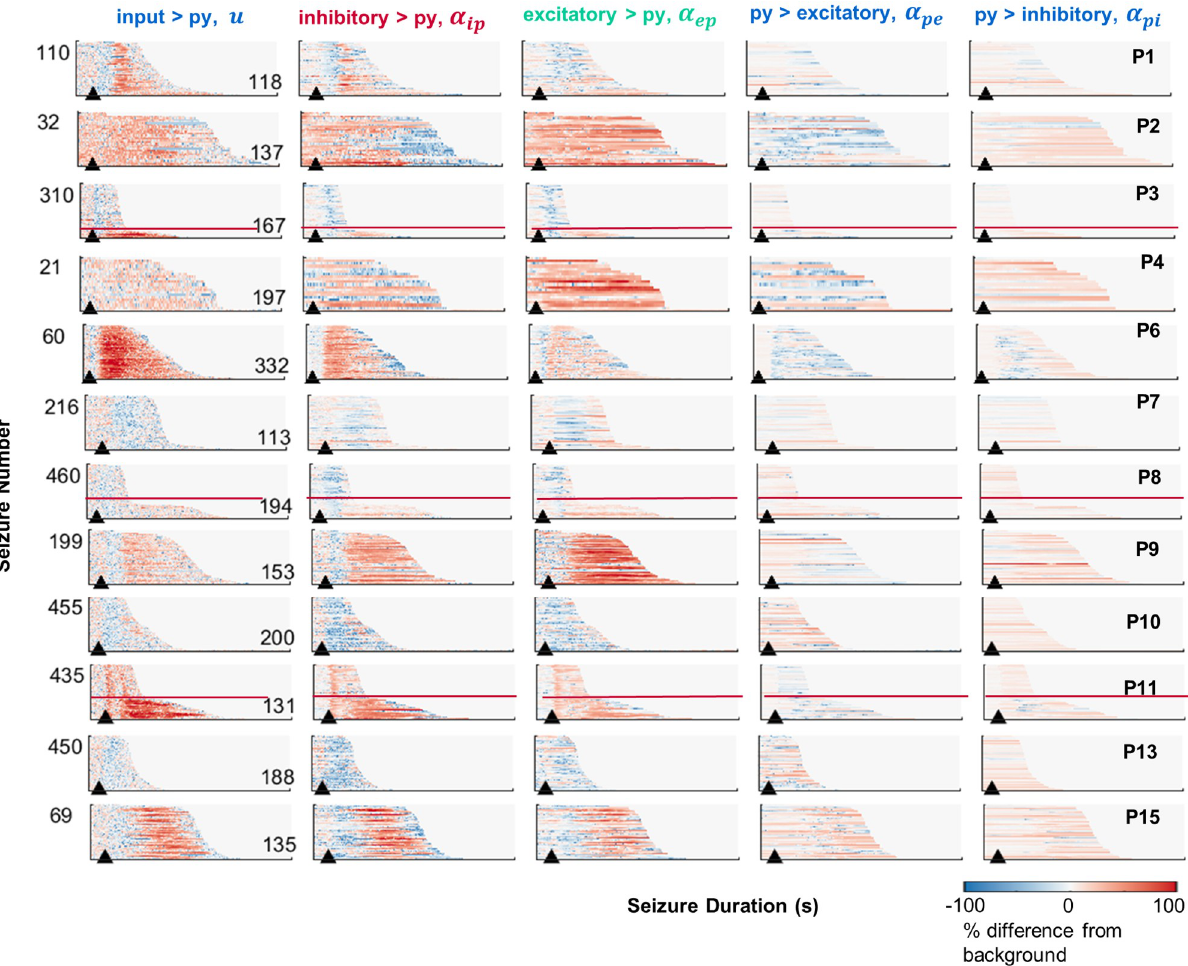
Fig 3. Estimated changes in parameter trajectories during every seizure. Each subpanel represents the connectivity strength for all seizures (sorted by duration) of a single representative channel for each patient (P1: Ch3, P2: Ch1, P3: Ch2, P4: Ch2, P6: 7, P7: Ch15, P8: Ch11, P9: Ch4, P10: Ch13, P11: Ch9, P13: Ch5, P15: Ch1). Data for all channels is provided online (https://github.com/pkaroly/Data-Driven-Estimation/tree/master/figures/ connectivity). Parameters are expressed as a percentage change from their pre-ictal background values (where zero reflects no change from the pre-ictal period). The pre-ictal period was defined from two minutes to one minute before seizure onset. Red lines mark the divisions between long and short populations of seizures within bimodal